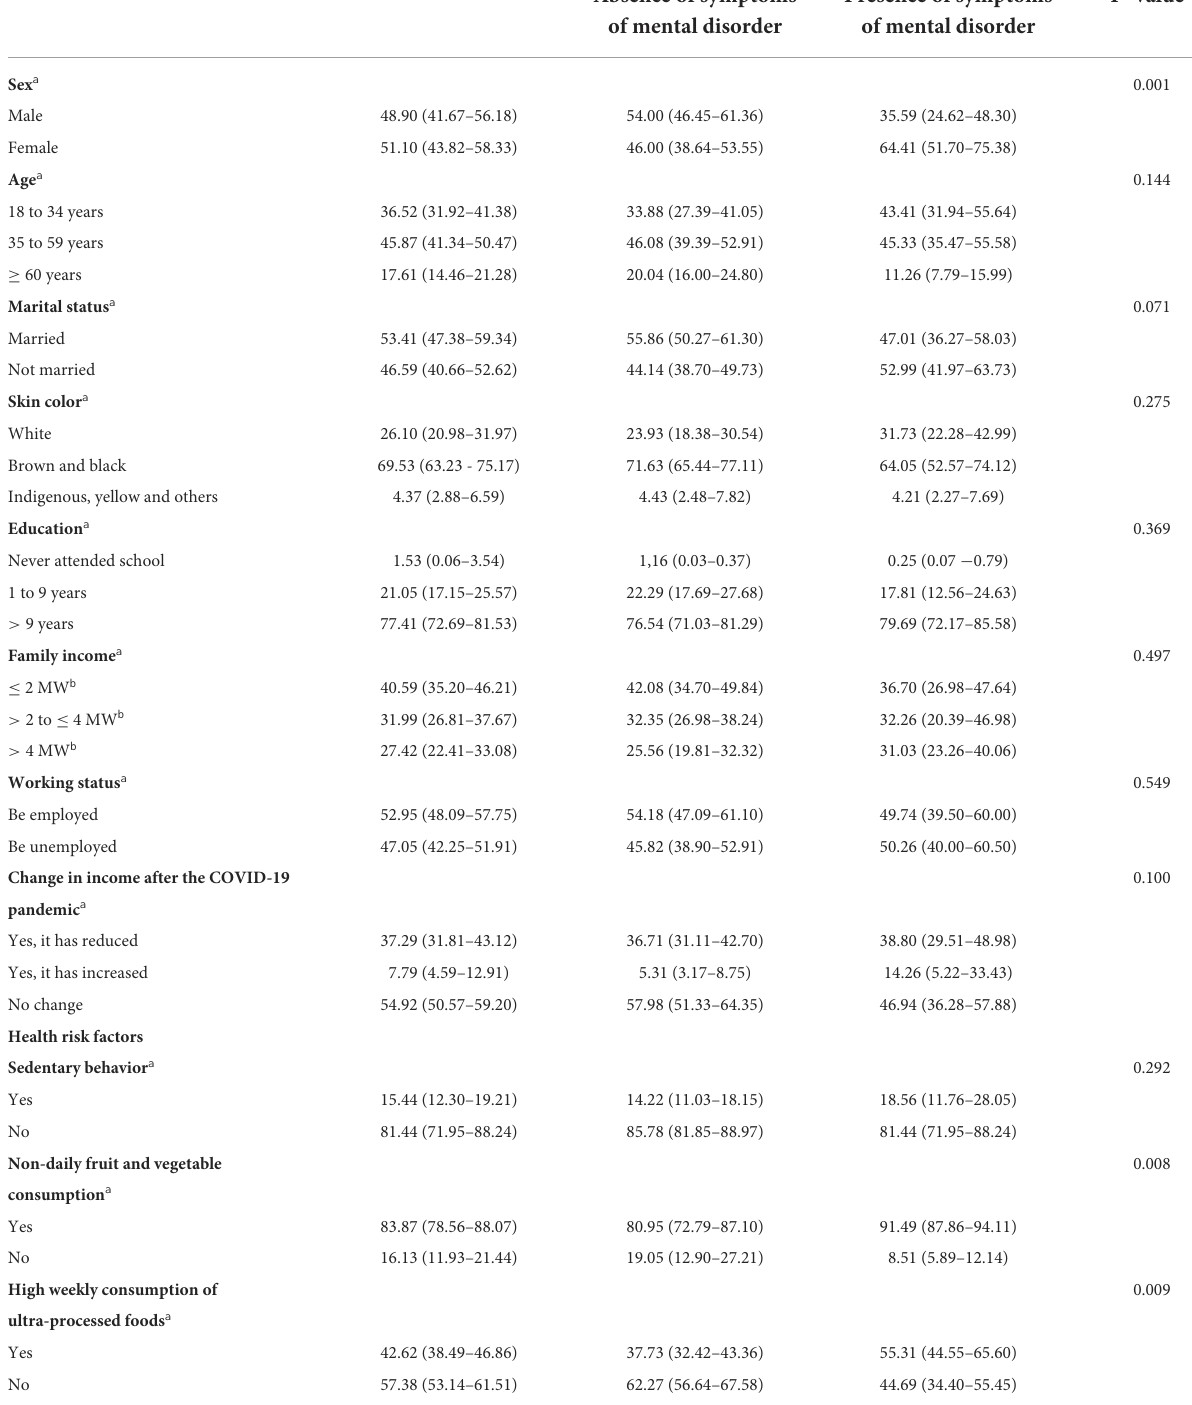
TABLE 1 Sociodemographic and mental health characteristics according to the outcome, the presence of symptoms of anxiety and depression, COVID Inconfidentes 2020.